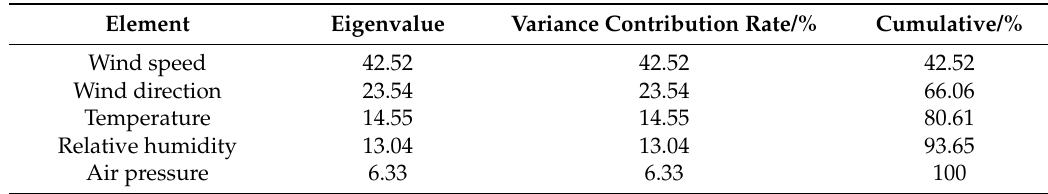
Table 4. Variance and principal component contribution rate.